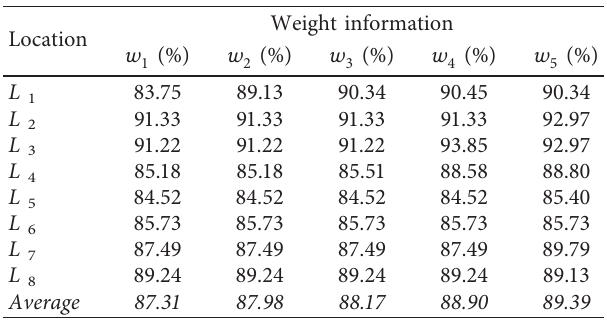
Table 10: The accuracy ratio of the haze warning system by Al- gorithm 3 with weight information. The threshold value of each weight is set to be 90% of the possible maximum.